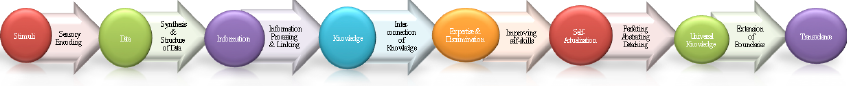
Fig. 2. Cognitive and Metacognitive processes required in order to move from a layer to another